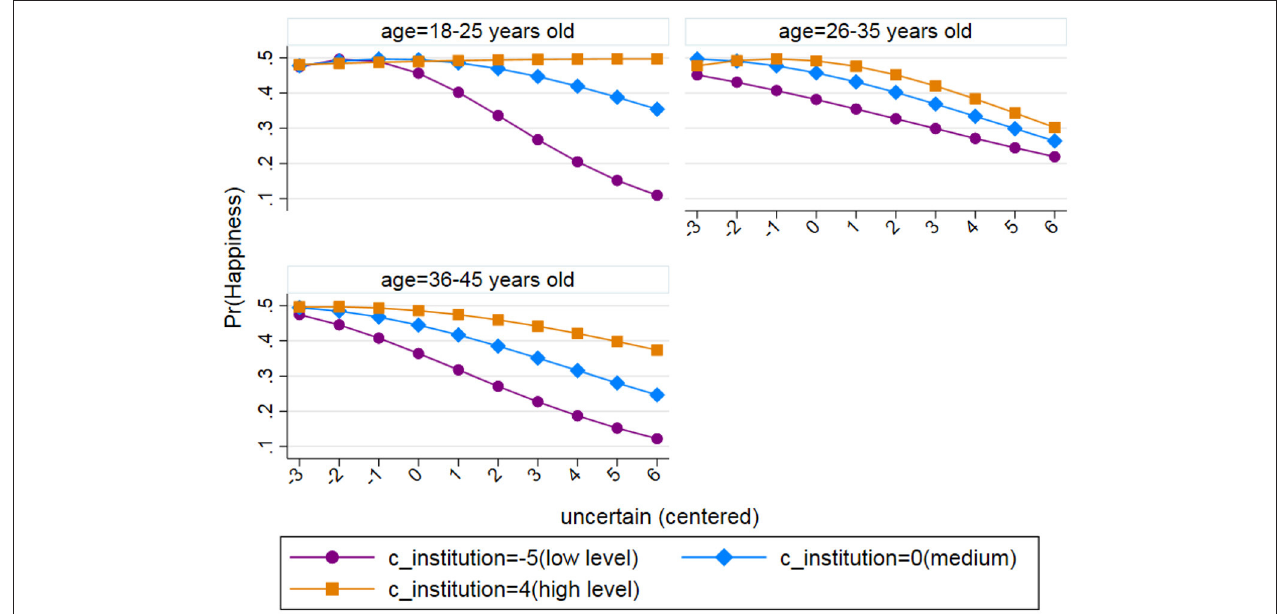
FIGURE 2 | Differences in the moderating effect of institutional evaluation for three age groups.